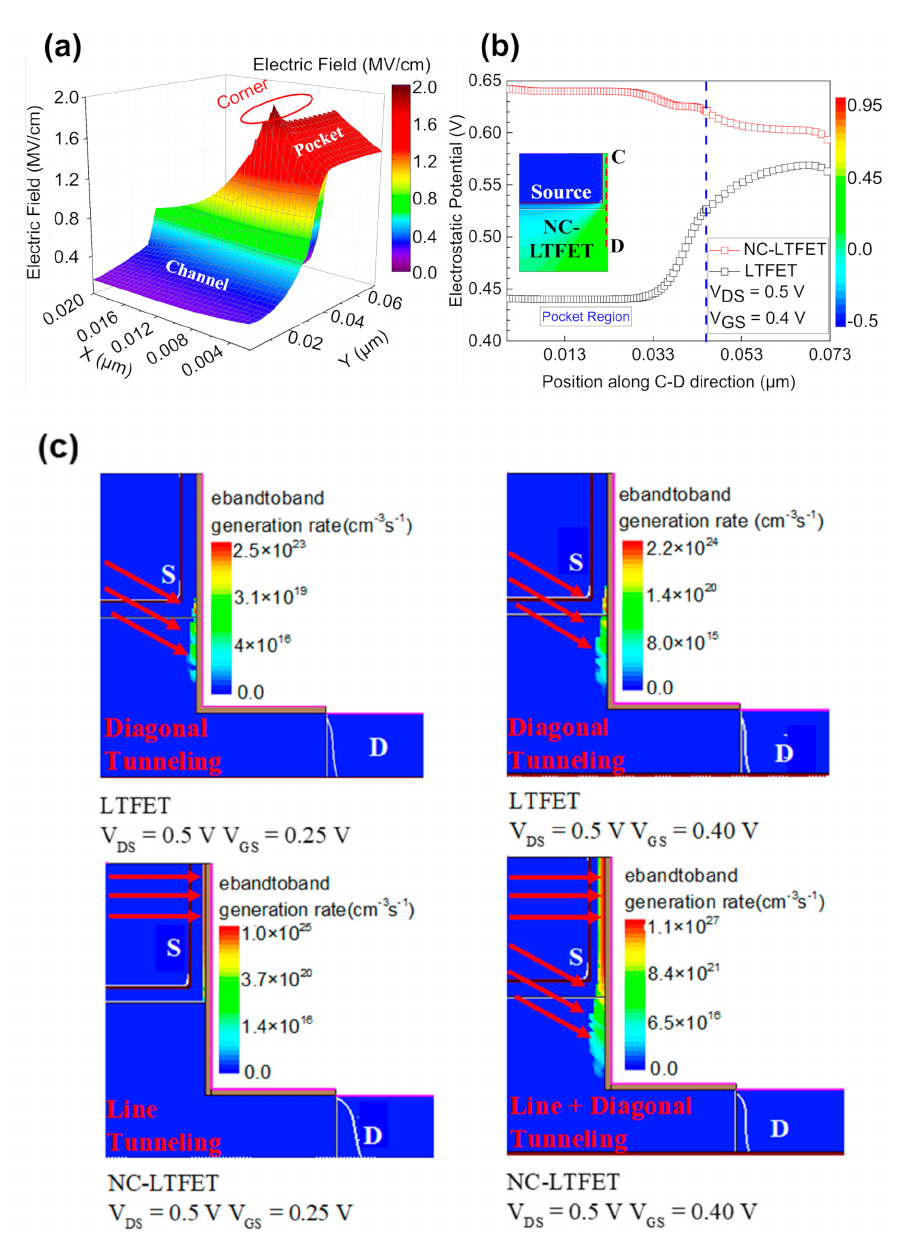
Figure 4. ( a ) The electric field distribution near the source region of LTFET at V GS = 0.4 V and V DS = 0.5 V, ( b ) the surface potential under the gate oxide along the C-D direction at V GS = 0.4 V and V DS = 0.5 V and ( c ) the electron band-to-band generation rate of LTFET and NC-LTFET at low gate